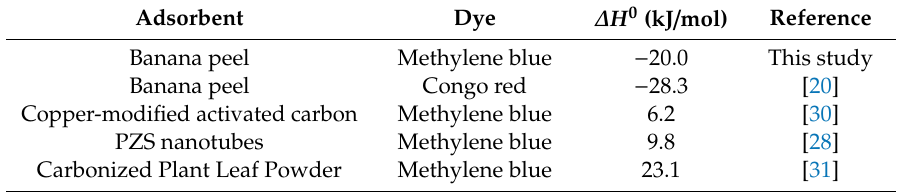
Table 4. Thermodynamic properties of adsorbents from